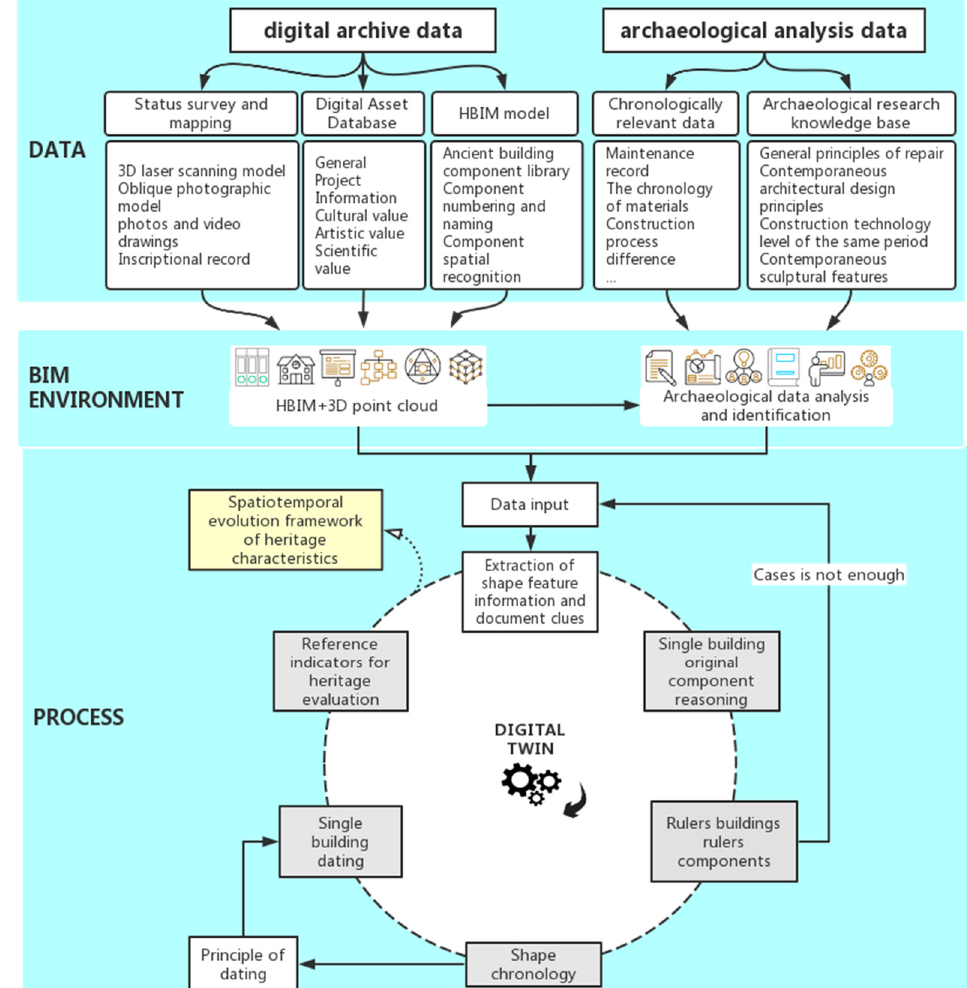
Figure 17. The Digital Twin process supports archaeological analysis.